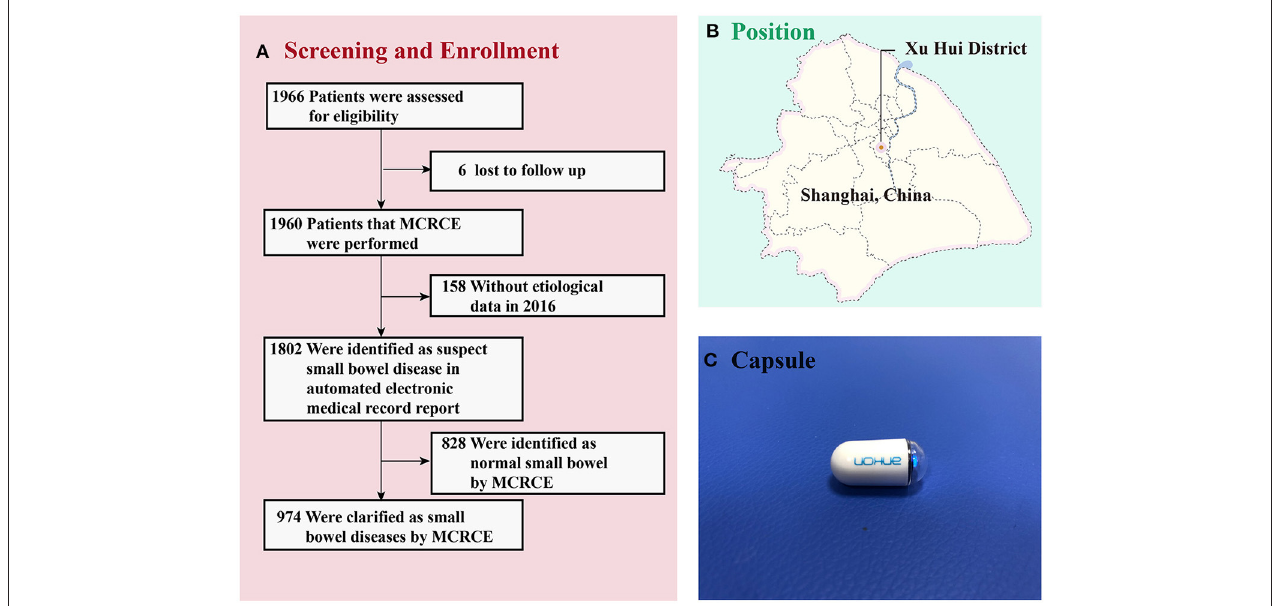
FIGURE 1 | (A) Screening and enrollment of patients in the study. (B) The place of recruitment in Shanghai (Shanghai Jiao Tong University Affiliated Sixth People’s Hospital). (C) The NaviCam Magnetically Controlled Capsule Endoscopy from Ankon Medical Technology Co., Ltd. MCRCE, magnetically controlled robotic capsule endoscopy.